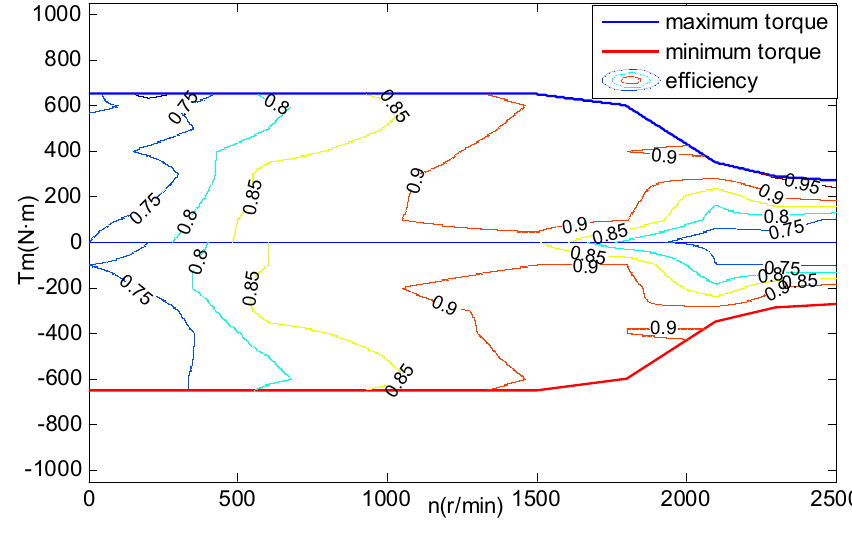
Figure 4. The motor efficiency map.